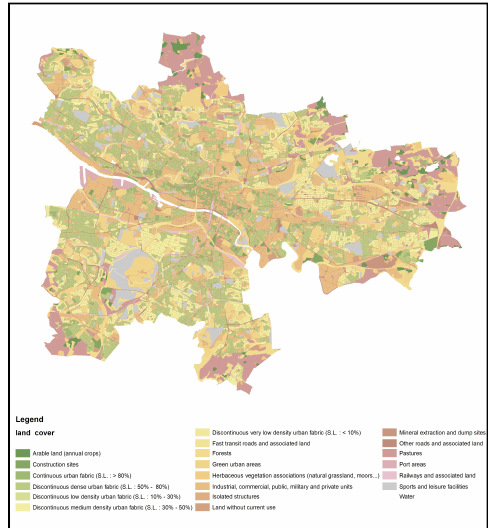
Figure 3 . Land cover types of